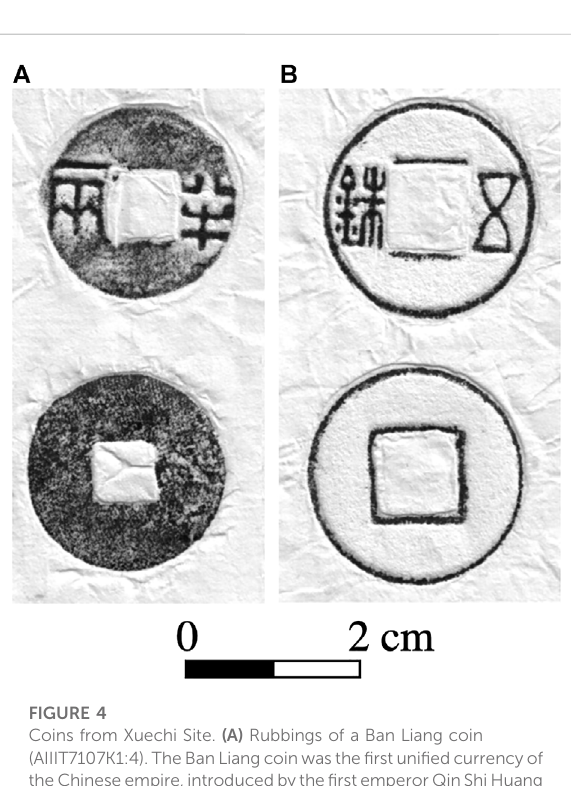
About 10 mg of the enamel powder was drilled along the tooth growth axis from the cusp to the enamel-root junction using a diamond-tipped Dremel tool. Then the samples were soaked in 5% weak acetic acid for one hour to remove diagenetic carbonate. Each sample was washed using deionized water for three times, dried and dissolved in 0.2 N HCl. The supernatant was dried down and then redissolved in 2.5 N HCl for Sr separation chemistry. For river water samples, after centrifuging the sample, approximately 5 ml of supernatant was dried on a hotplate at 100 ° C. All samples were dissolved in 2.5 N HCl. The strontium was separated from the matrix using AG50W × 12 cation-exchange resin (200 – 400 mesh). Isotopic ratio measurements were using a Triton Plus thermal ionization mass spectrometer (TIMS) (Thermo Fisher Scienti fi c) housed at the Institute of Geology and Geophysics, CAS, using